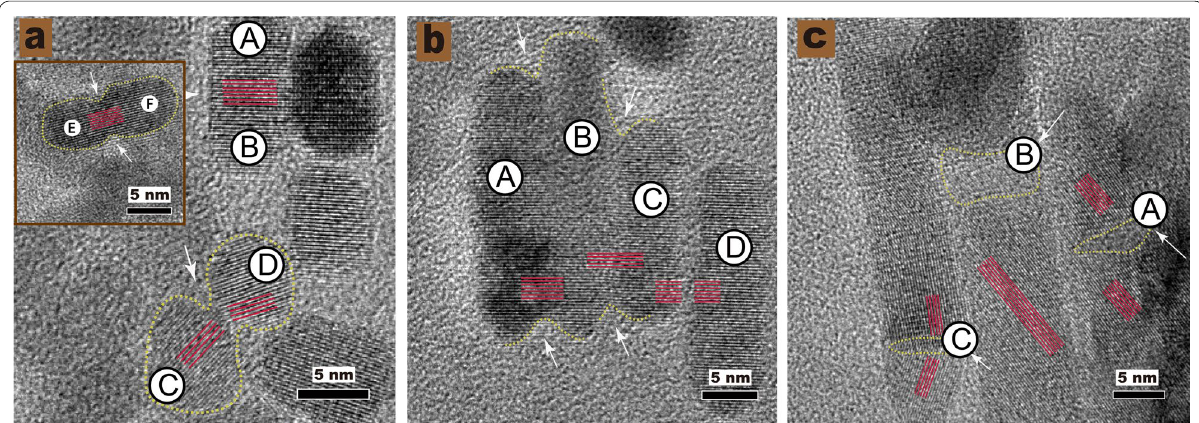
Fig. 3 The HRTEM images of pristine ZnO NPs. a ZnO NPs (~ 7 nm); b ZnO NPs (~ 18 nm); c ZnO NPs (~ 49 nm). The ZnO NPs formed layer-by-layer either parallelly or perpendicularly to the C-axis. The arrows indicate the boundaries of the pristine